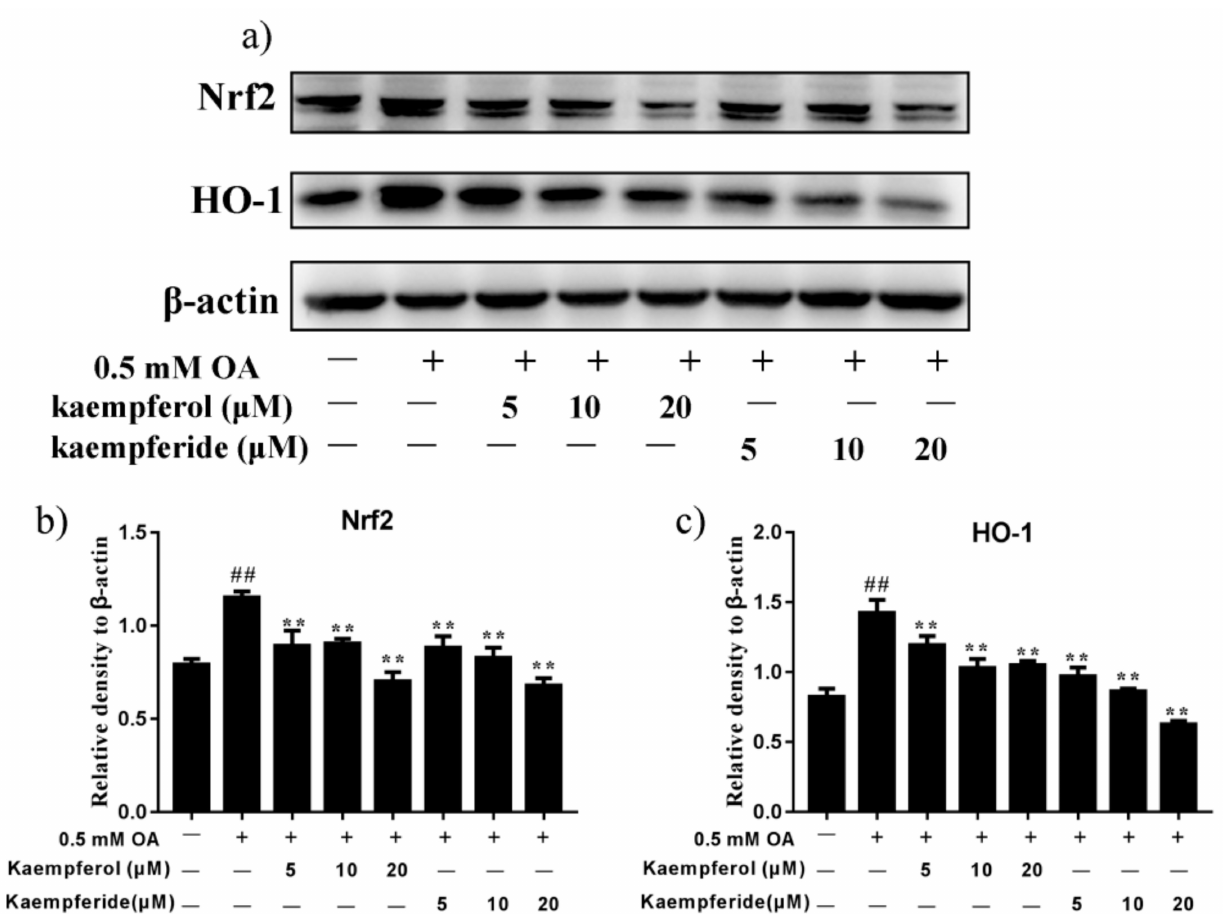
Figure 8. Kaempferol and kaempferide inhibited expression of Nrf2 and HO-1 in OA-induced HepG2 cells. HepG2 cells were incubated with different concentrations of kaempferol or kaempferide in the presence of 0.5 mM OA for 48 h followed by western blot analysis of the expression of Nrf2 and HO-1. ( a ) Representative blots. ( b ) Quantification results of the expression of Nrf2. ( c ) Quantification results of the expression of HO-1. Data were expressed as mean ± SD of three independent experiments. ## p < 0.01, compared with vehicle-treated control cells (Con); ** p < 0.01, compared with OA-treated cells